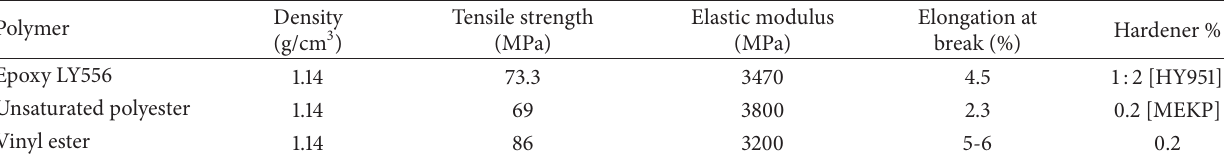
Table 1: Physical and mechanical properties of polymers (manufacturer data sheet). Polymer